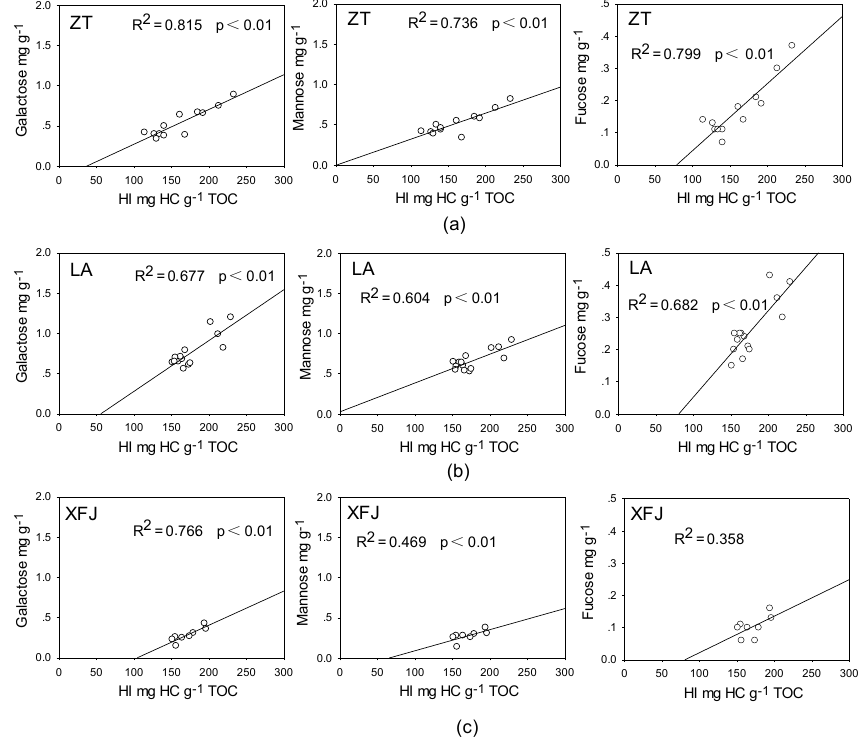
Figure 4. Relationship of HI with monosaccharide compounds in the ZT, LA, and XFJ reservoirs (for LA, the sample at 8–10cm depths and at 30–34cm depths were excluded; for XFJ, samples below 16cm were excluded). The HI data are cited from Duan et al.